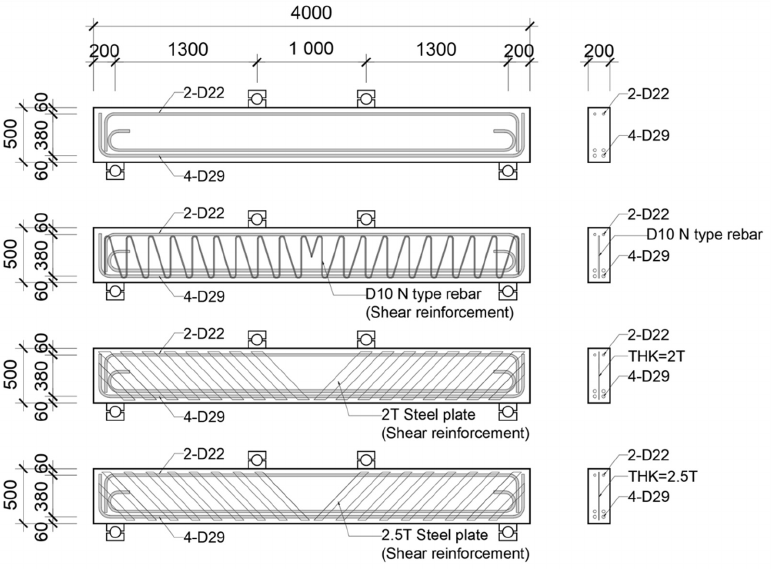
Figure 2. Test specimens’ fabrication. ( a ) reinforcement detail and gauge attachment. ( b ) Formwork installation. ( c ) Concrete casting.